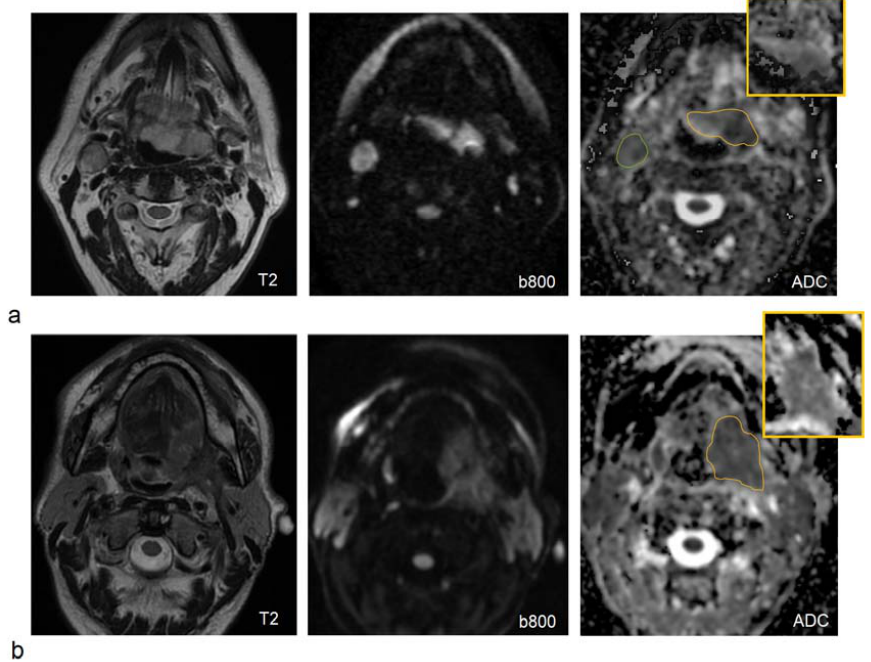
Figure 5. HPV-negative OPSCC in a 72-year-old non-smoker non-alcoholic male. MRI shows a lesion into the base of the tongue with floor of the mouth involvement, characterized by a hyperintense signal on both T2 ‐ weighted image and DWI obtained with b = 800 s/mm 2 . ADC and D maps (the latter was cropped in the upper right yellow box) indicate slightly decreased values in the us ‐ er ‐ defined primary tumor contour (yellow line), with 50th percentiles of 1.52 × 10 − 3 mm 2 /s and 1.29 × 10 − 3 mm 2 /s, respectively. The pathological lymph node into the IIa level (green line) shows a quite homogeneous signal intensity on the T2 ‐ weighted image and rather inhomogeneous signal inten ‐ sity on DWI, consistent with a low Inverse Difference Moment of ADC LN of 0.28 ( a ). These patients were correctly classified as HPV ‐ negative by imaging ‐ based or combined models (Model 1 ‐ Model 6) but incorrectly classified as HPV ‐ positive by the clinical model (Model 7), smoke and drinking habits being peculiar to a patient affected by an HPV ‐ related malignancy. Bottom: HPV ‐ positive OPSCC in a 67 ‐ year ‐ old heavy smoker and alcoholic male. MRI shows a lesion into the base of the tongue, with left palatine tonsil involvement, characterized by a quite homogeneous and moderate hyperintense signal on T2 ‐ weighted image and DWI ( b ). ADC and D maps indicate moderately decreased values in the user ‐ defined primary tumor contour (yellow line), with the 50th percentile equal to 1.33 × 10 − 3 mm 2 /s and 1.12 × 10 − 3 mm 2 /s, respectively. This patient was misclassified by all the proposed models, having smoke/drinking habits and ADC/D characteristics more indicative of an HPV ‐ negative tumor. 4. Discussion In the present investigation, we explored the potential of DWI ‐ based radiomics of both primary tumors and metastatic nodes, in conjunction with patient ‐ related factors, to determine the patient HPV status in a homogeneous cohort of OPSCCs. The role of DWI in differentiating HPV ‐ positive from HPV ‐ negative patients was concordantly reported in previous studies, which found a marked reduction in ADC values and a more leptokurtic and skewed right ADC histogram in HPV ‐ positive tumors, compared to HPV ‐ negative tumors [18,34–37]. This was attributed to the peculiar tissue architecture of HPV ‐ positive tumors, characterized by more densely packed cells, a smaller tumor ‐ stroma component, and higher levels of tumor ‐ infiltrating lymphocytes.